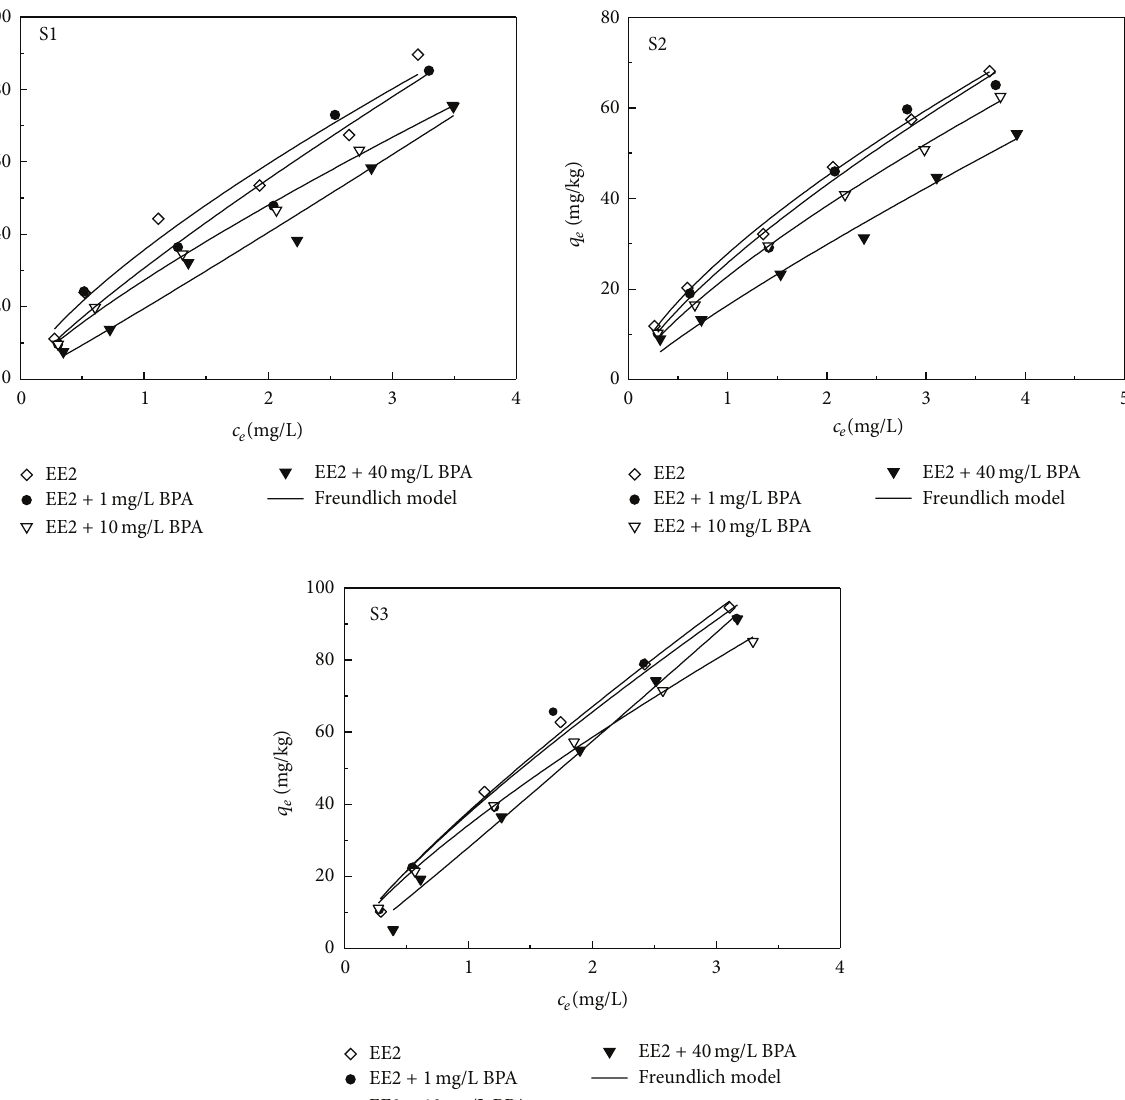
Figure 4: Effects of BPA on the adsorption isotherms of EE2 in different sediment samples. The EE2 concentration was